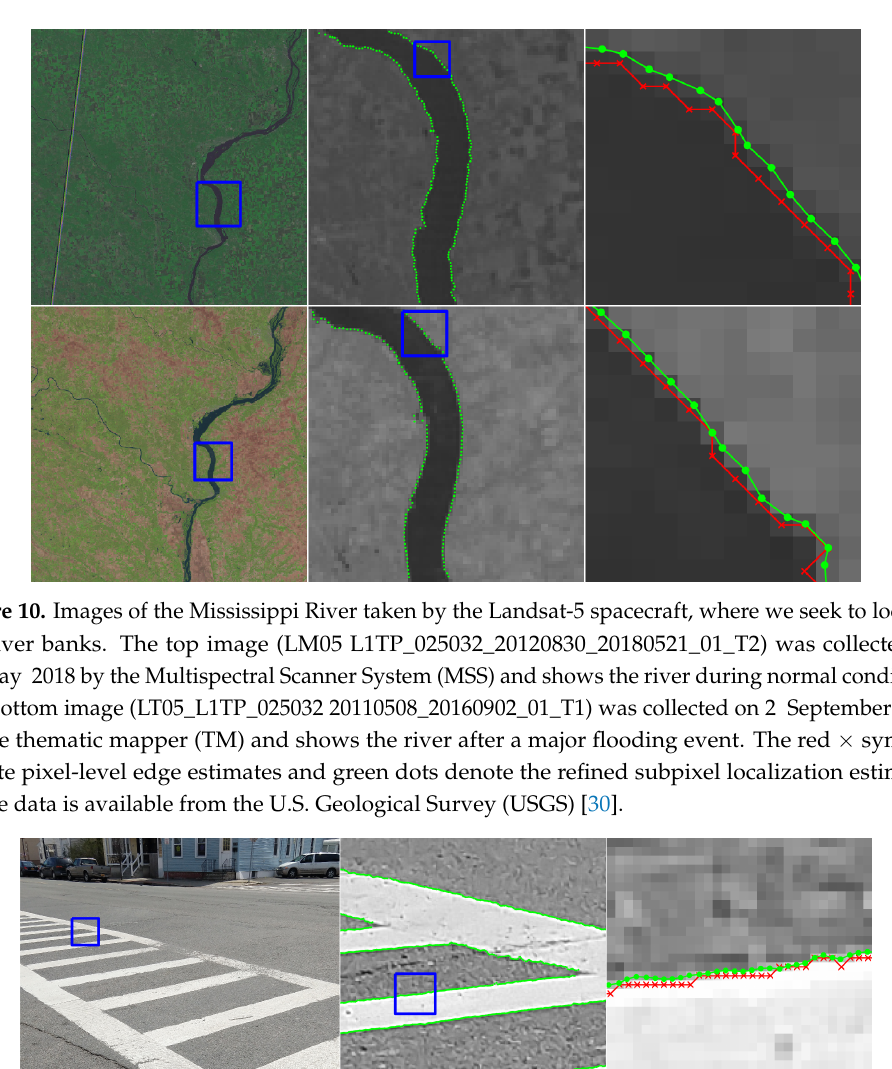
Figure 11. Image of a pedestrian crosswalk in Watervliet, NY, where we seek to localize the edges of the painted surface markings. The red symbols denote pixel-level edge estimates and green dots denote the × refined subpixel localization estimates. Original image collected by the authors with a personal